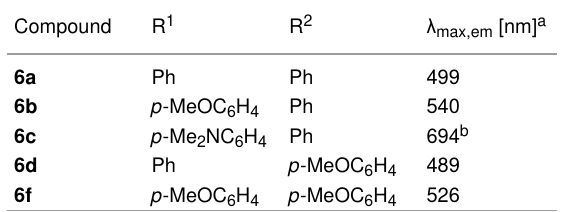
Table 9: Photophysical properties of selected α -pyrones 6 in the solid